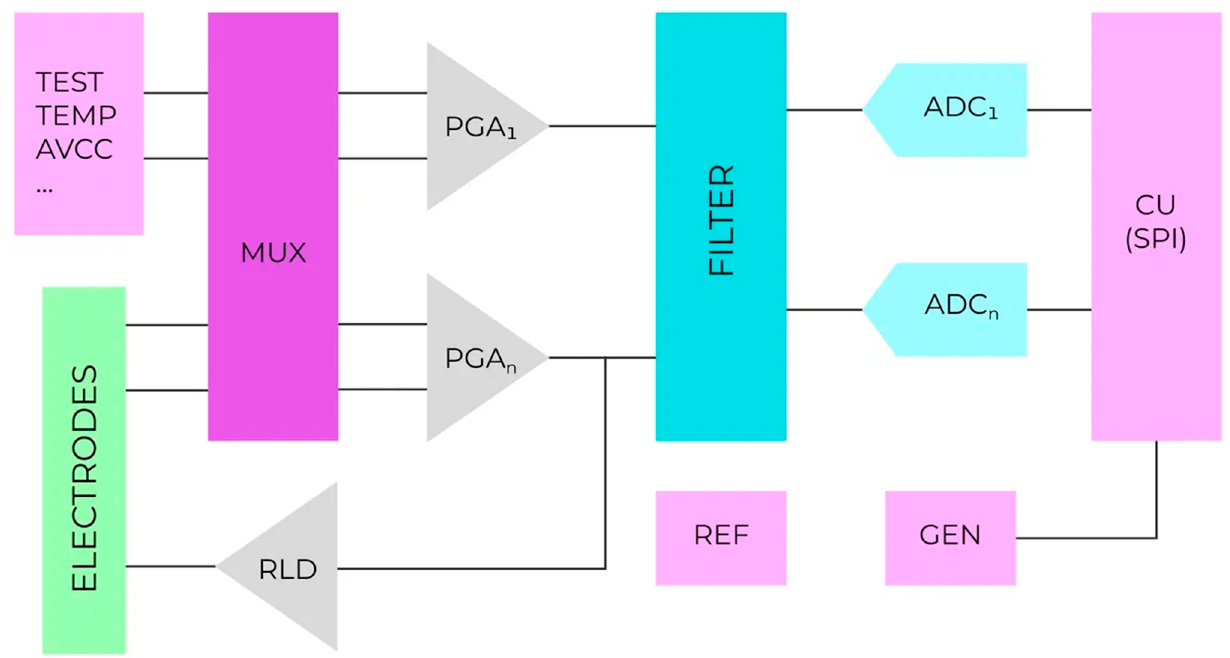
Figure 12. Simplified structure of AFE for electrical potential registration.